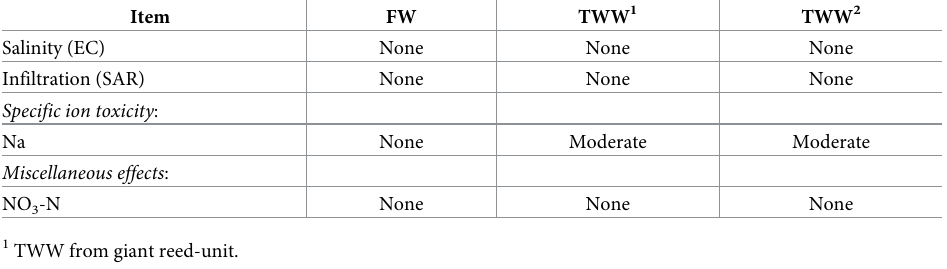
Table 7. Restrictions on use of freshwater and treated wastewater obtained from HSSFs CW in irrigation.